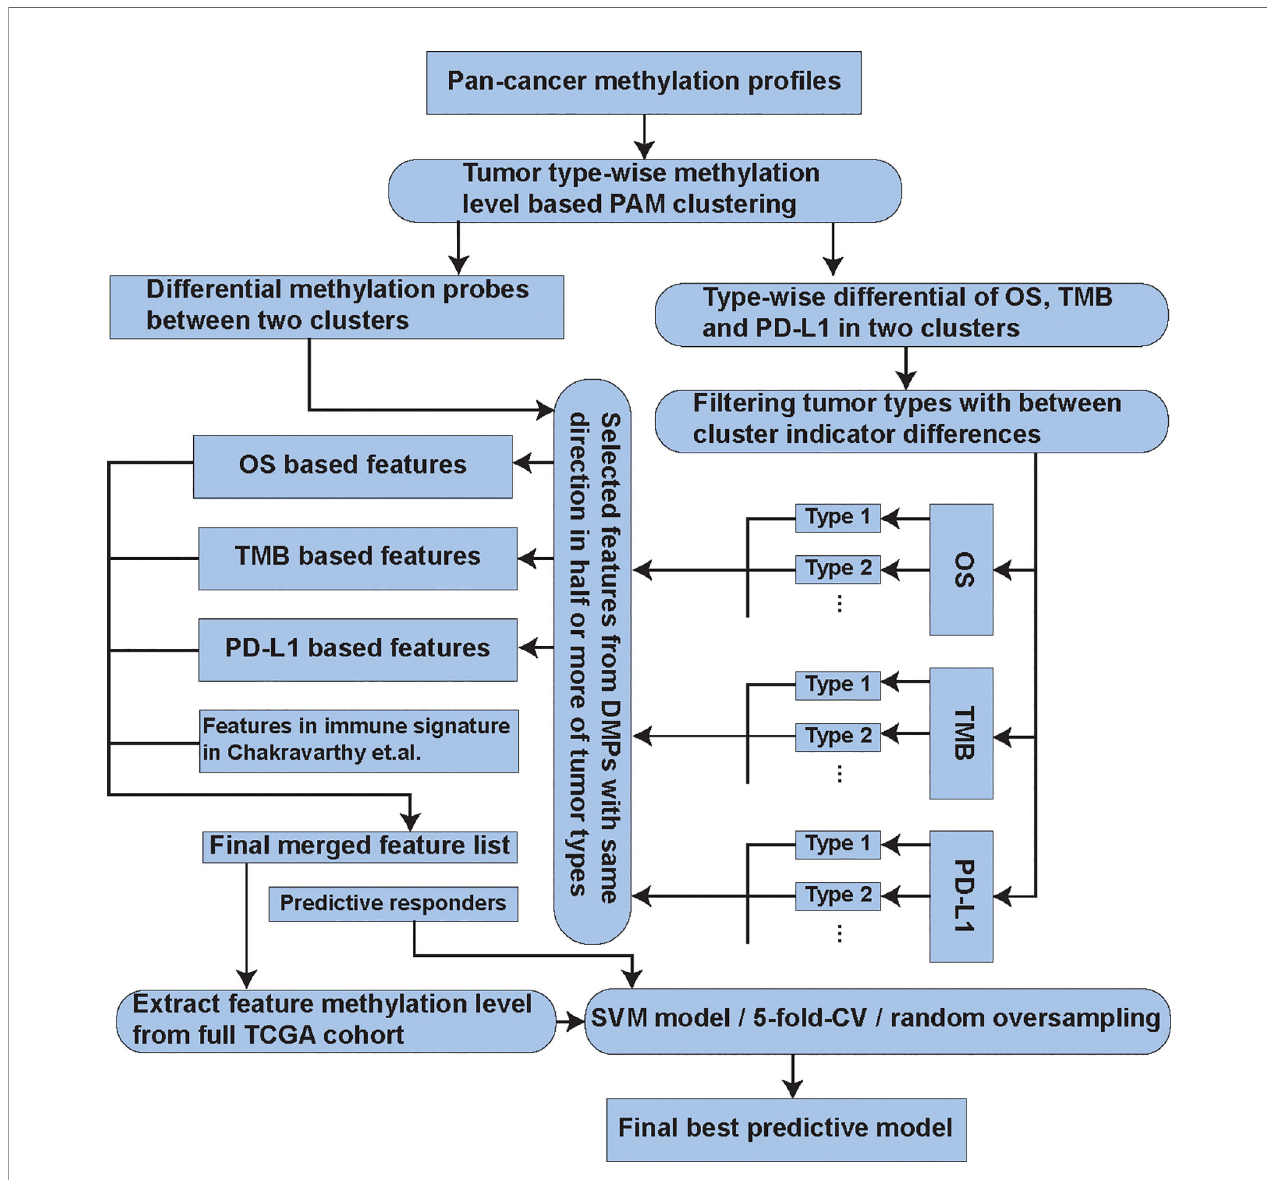
FIGURE 1 | The fl ow chart describing the process of the feature selection and model